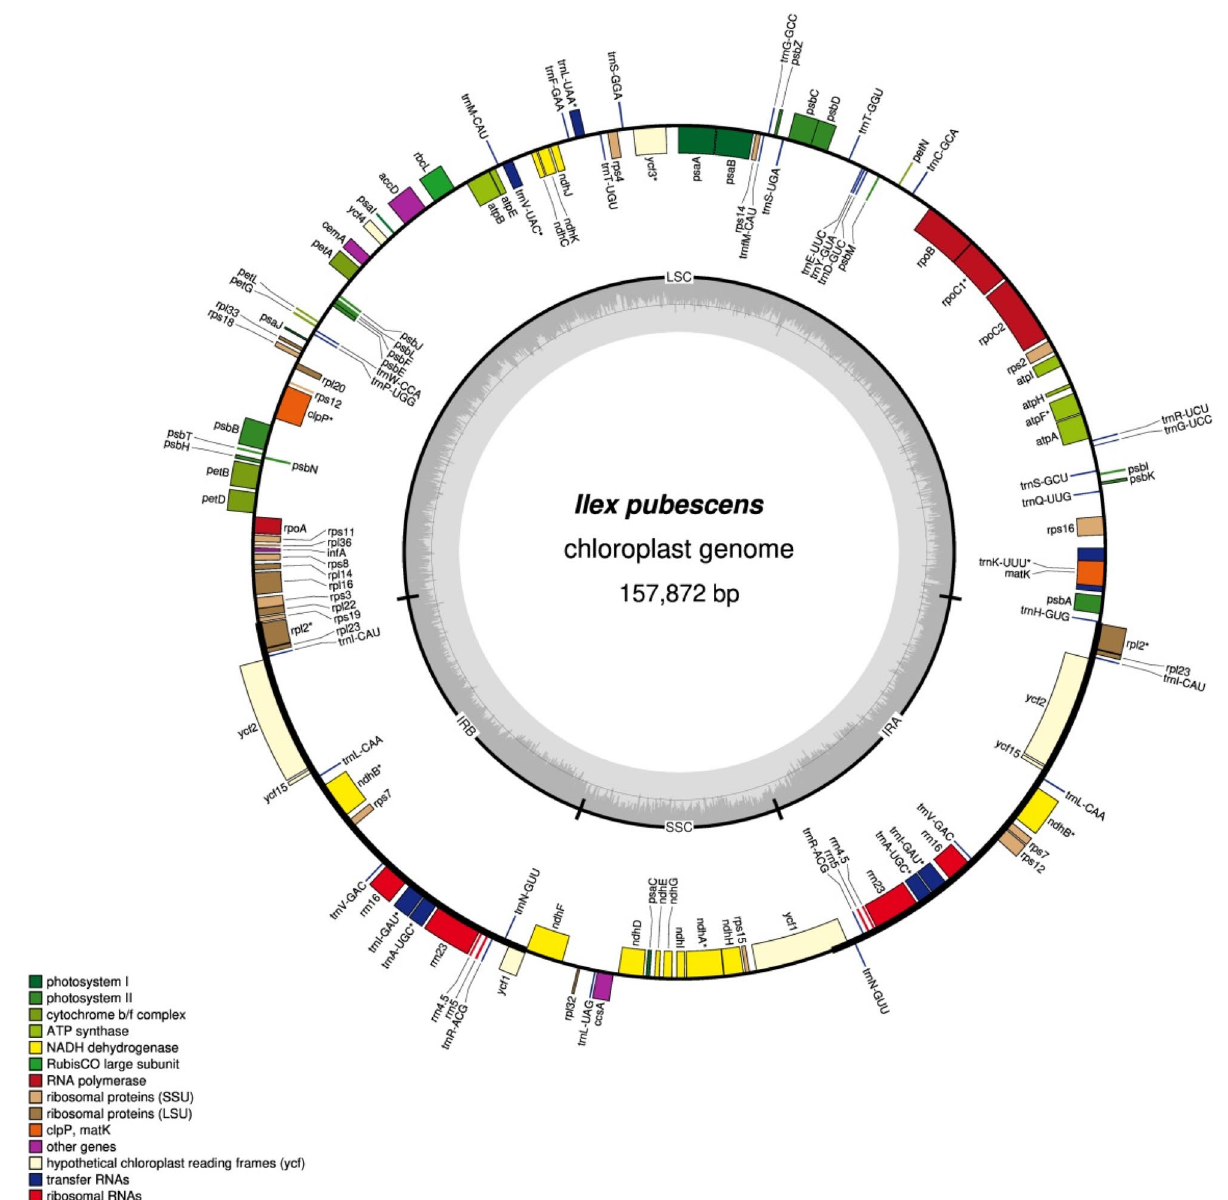
Figure 1. Chloroplast genome map of I. pubescens. The genome structure and gene arrangement in the 19 Ilex species were conserved. Introns containing coding regions are indicated with asterisks. The inner grey circle represents the GC content of each region. Genes shown in the inner circle are transcribed clockwise and vice versa. Genes belonging to different functional groups are indicated in different